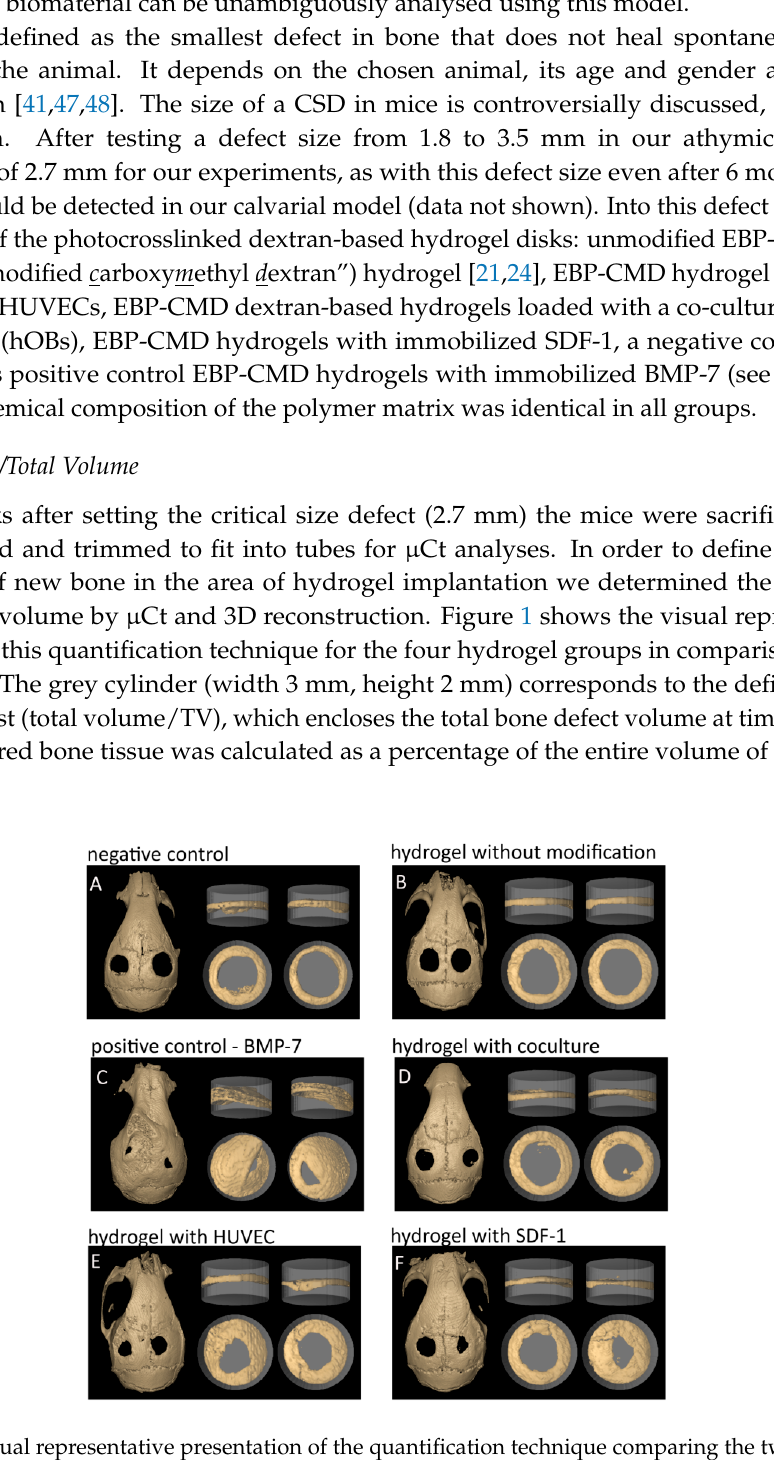
Figure 1. Visual representative presentation of the quantification technique comparing the two control groups to the four hydrogel groups. The grey cylinder (width 3 mm, height 2 mm) corresponds to the defined standard volume of interest representing the total volume (TV). The bone growth inside the cylinder represents the bone volume for the calculation of the ratio bone volume (BV)/ total volume (TV). ( A ) negative control; ( B ) hydrogel without modification; ( C ) BMP-7: positive control; ( D ) hydrogel with coculture; ( E ) hydrogel with HUVEC; and ( F ) hydrogel with